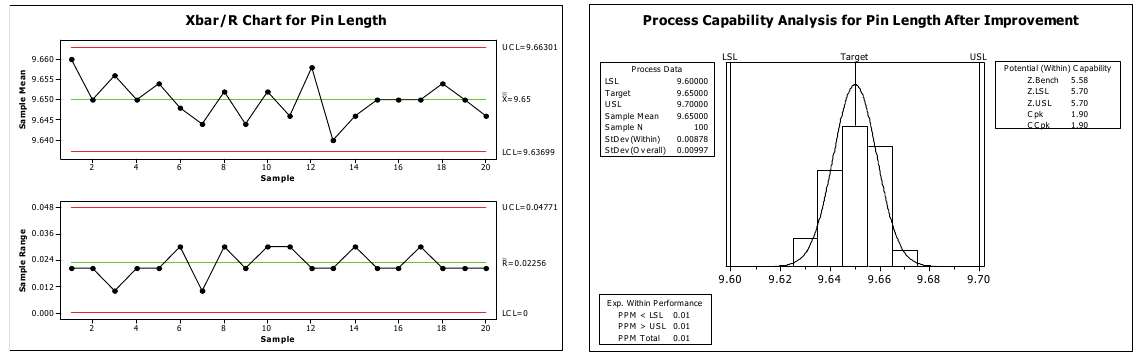
Fig. 8. X bar/R Graph for Pin Length Post Measures Fig. 9. C pk Analysis for Pin Length Data Post Measures